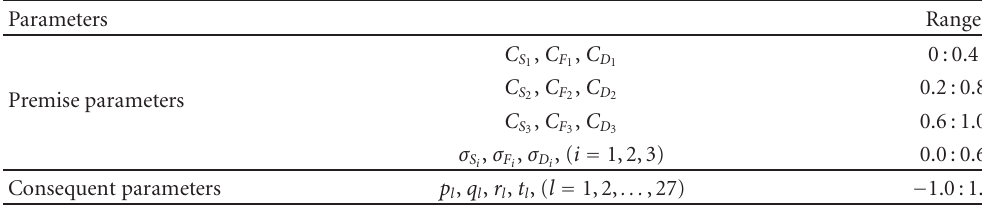
Table 10: Ranges of the premise and consequent parameters of FO Sugeno fuzzy model.